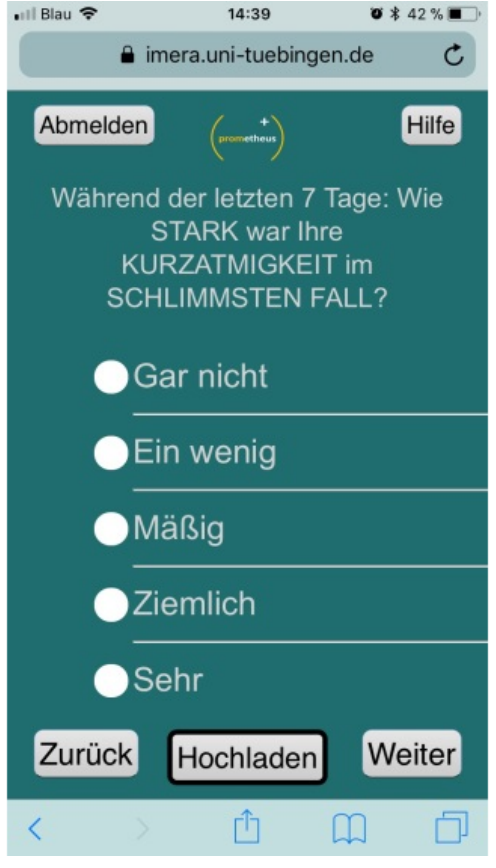
Figure 1. Screenshot of PROMetheus during usage (functions of the buttons: top left=sign out, top right=help, bottom left=back, bottom center=upload all items answered so far, and bottom right=next). The question displayed assesses the severity of shortness of breath with a 5-tier scale from not at all to